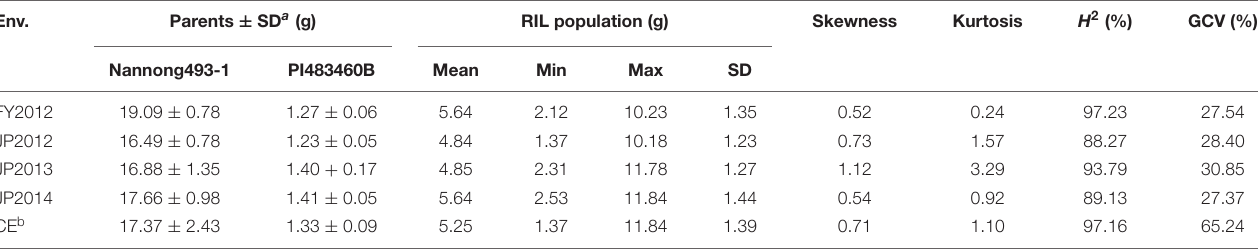
TABLE 1 | Descriptive statistics, broad-sense heritability ( H 2 ), and genotypic coefficient of variation (GCV) of 100-seed weight in NJIR4P RIL population and two parental lines viz ., Nannong493-1 and PI 483460B.